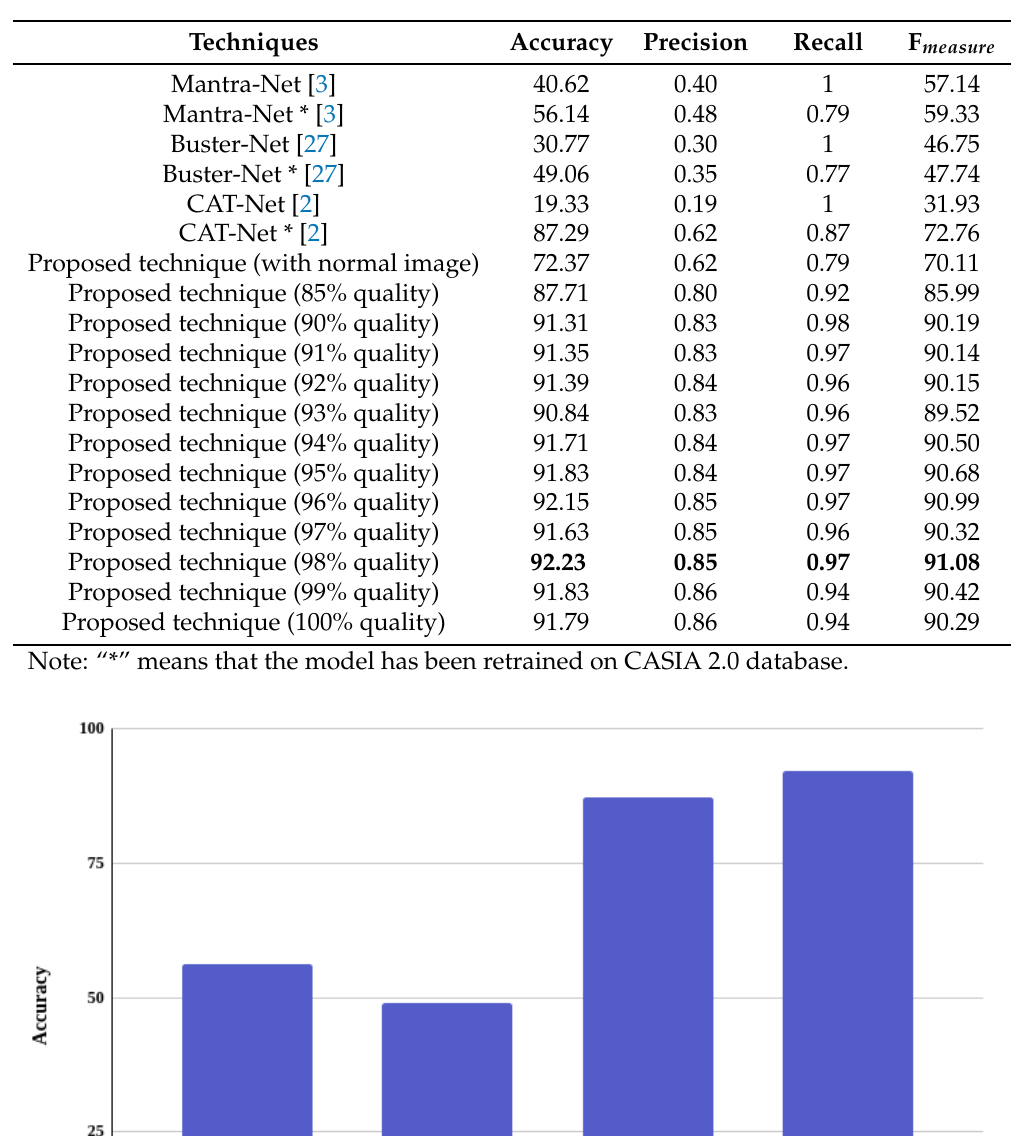
Table 2. Accuracy comparison of the proposed technique with other techniques on CASIA 2.0 database.